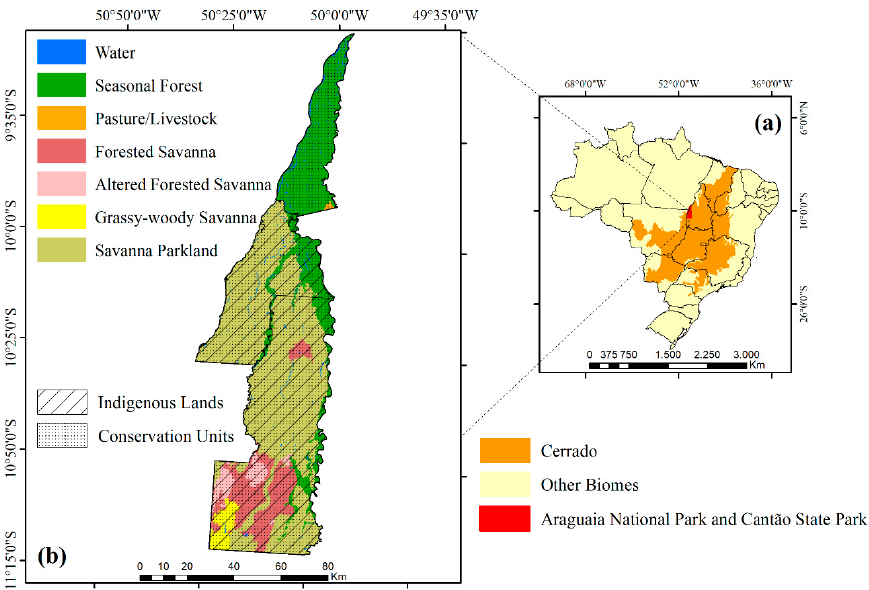
Figure 2. Araguaia National Park and Cantão State Park (ANP-CSP): ( a ) location in Brazilian Cerrado, and ( b ) land use/cover map.